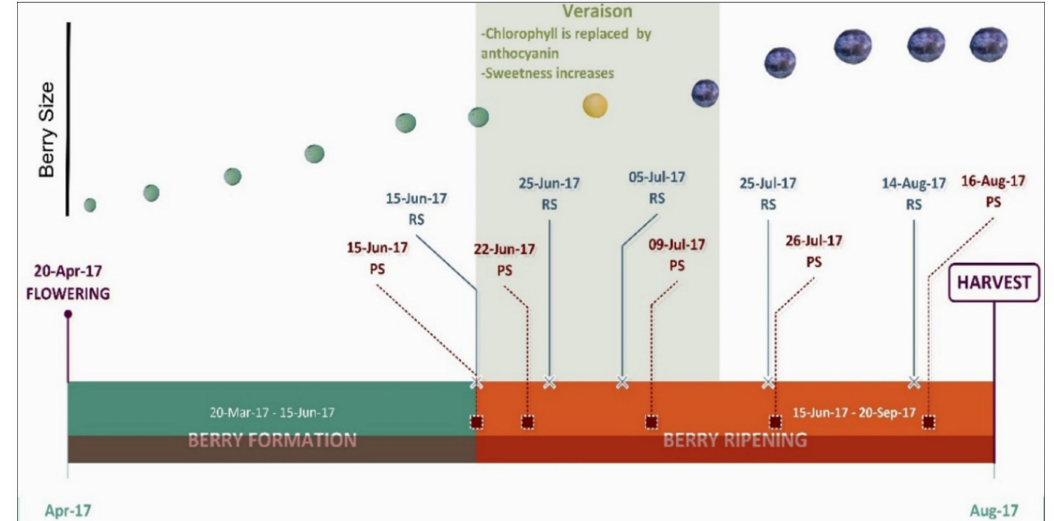
Figure 4. Temporal distribution of the proximal- and remote-sensing data during the vineyard growing